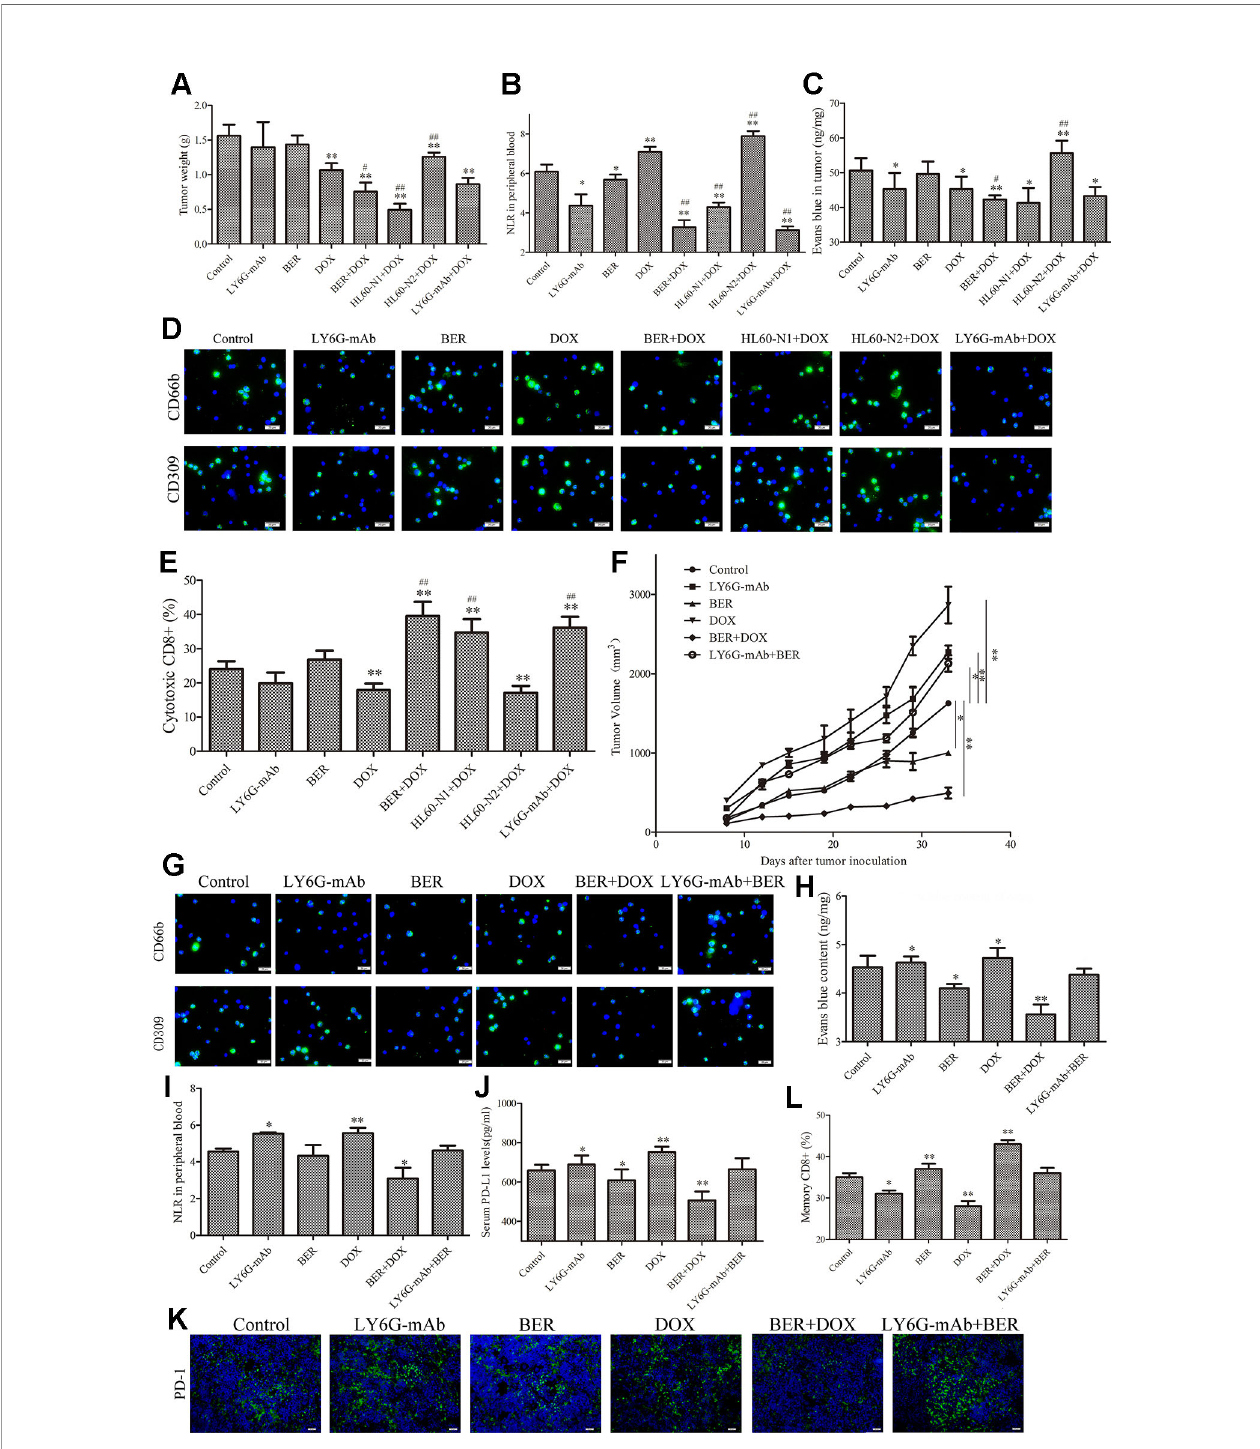
FIGURE 6 | N2-like neutrophils are related to tumor sensitivity to DOX and tumor secondary immunity and immune memory. (A) Tumor weight (n = 6). (B) Tumor tissue permeability to Evans blue (n = 6). (C) Neutrophil to lymphocyte ratio (NLR) in peripheral blood in tumor-bearing mice (n = 6). (D) Bone marrow neutrophil immunophenotypes indicated by immuno fl uorescence (n = 6, 40×). (E) Spleen cytotoxic CD8+ cell rate (n = 6, 40×). (F) Tumor growth curve in a tumor rechallenge immune study. (n = 6). (G) Bone marrow neutrophil immunophenotypes indicated by immuno fl uorescence (n = 6, 40×). (H) Tumor tissue permeability to Evans blue (n = 6). (I) NLR in peripheral blood (n = 6). (J) Serum PD-L1 levels (n = 6). (K) Spleen tissue PD-1 expression indicated by immuno fl uorescence. (n = 5, 40×). (L) Spleen memory CD8+ cell rate (n = 6). The data present mean ± SD, the experiments were repeated three times, and statistical signi fi cance was determined by a t-test. *P < 0.05, **P < 0.01 vs . control; # P < 0.05, ## P < 0.01 vs . DOX. DOX, doxorubicin; BER,